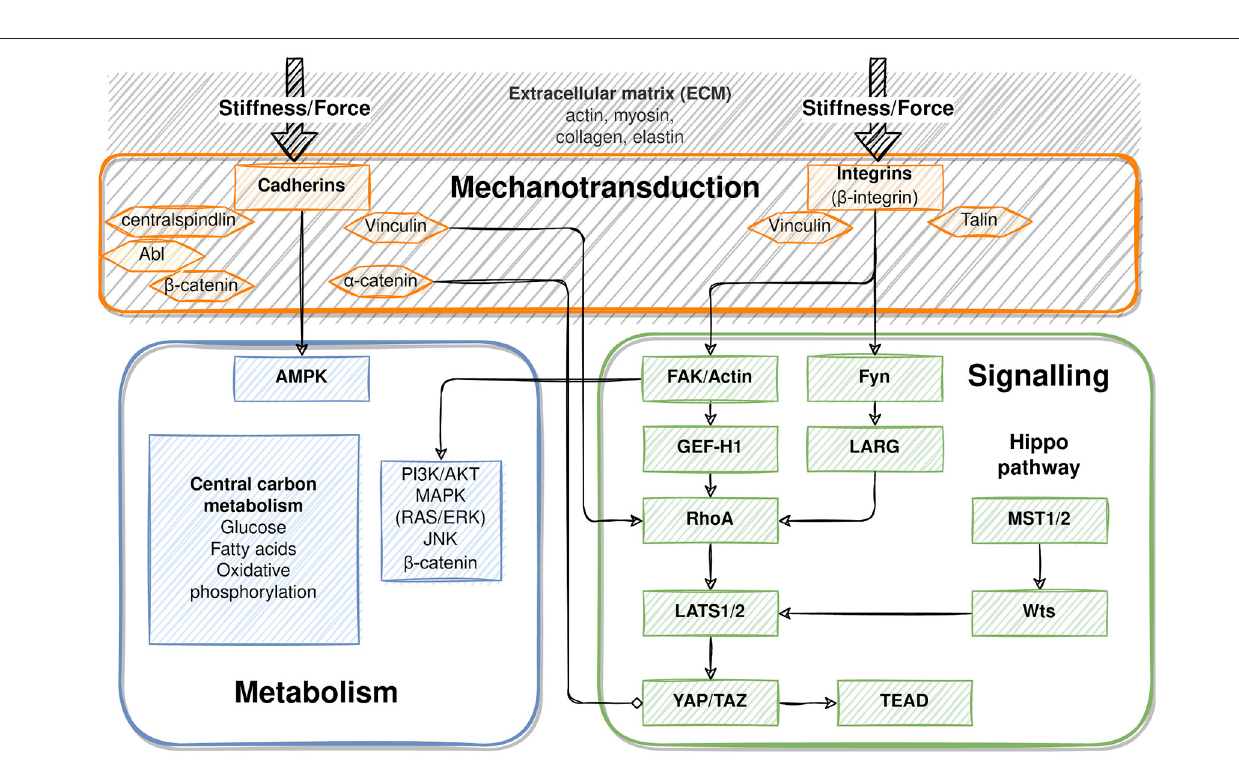
FIGURE 5 | Cellular adaptations to changes in tissue perfusion and mechanical properties (mechanotransduction, signaling, metabolism). The extracellular matrix (collagen, proteoglycans) plays an important role in how changes in perfusion and pressure are translated to changes in stiffness and force. Changes in stiffness and force are sensed by cadherins and integrins (mechanotransduction), which transfer the information via signaling cascades. A main signaling route is the FAK to YAP/TAZ pathway, with important crosstalk from the Hippo pathway. Important signaling pathways regulating metabolism can be modified due to mechanotransduction, among them AMPK, PI3K/AKT, MAPK, JNK and β -catenin which regulate central metabolic functions. See section 2.5 for